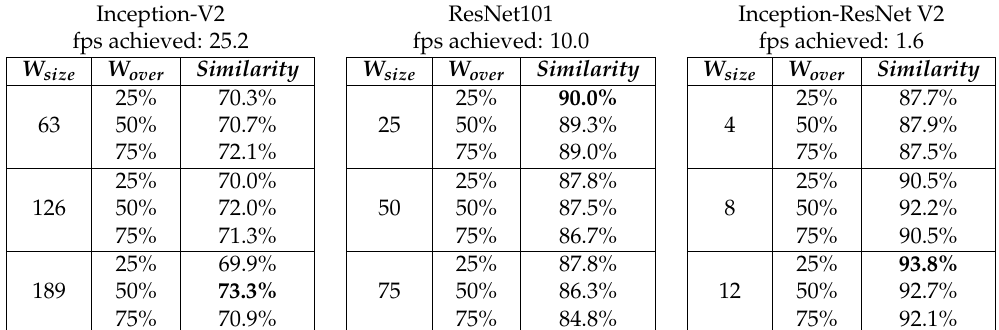
Table 5. Quantification results of Inception-ResNet V2, Inception V2 and ResNet101 neural network architectures. Bold data indicates the highest score obtained for each